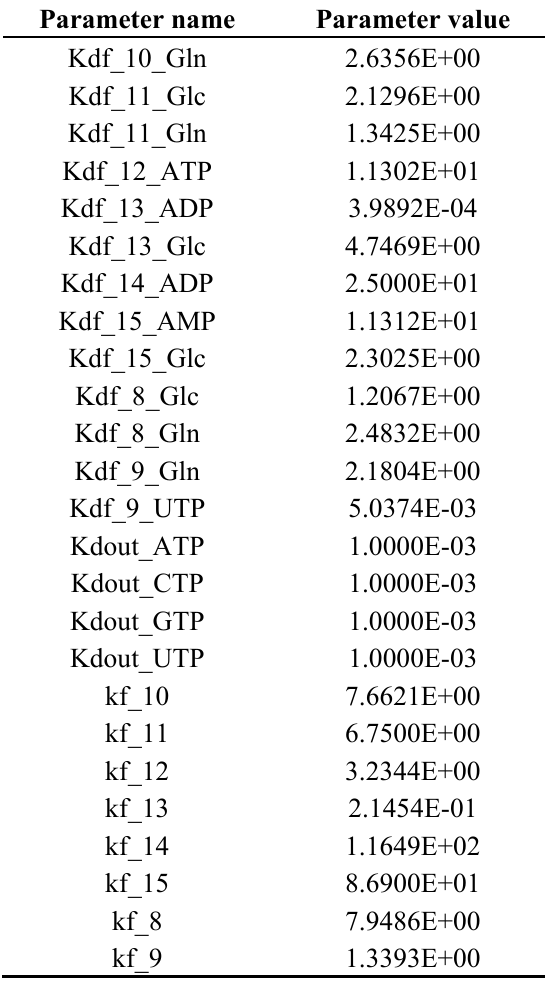
Table A5. Nucleotide model parameter